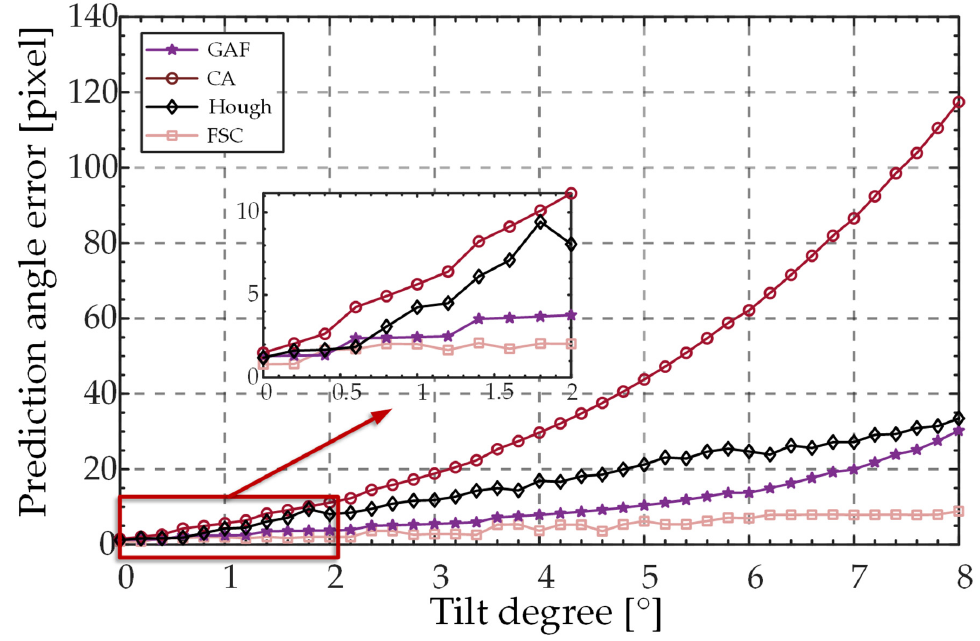
Figure 6. Extraction error of the peak position of light spot by different